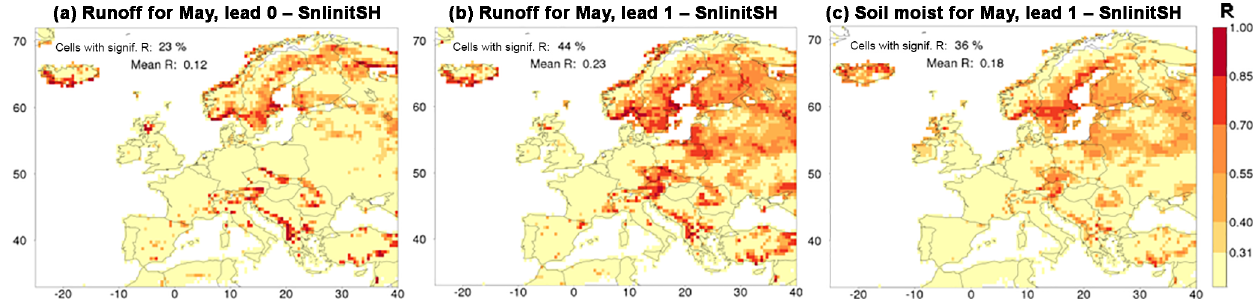
Figure 8. Example illustrating that skill in run-off for a target month may increase with lead time, namely for run-off in May as target months 0 (a) and 1 (b) in the SnInitSHs. Skill in soil moisture in the SnInitSHs, for May as lead month 1, is shown (c) , because it provides part of the explanation for the mechanism causing the increase in skill with lead time. For more explanation, see Figs. 1a and 6.